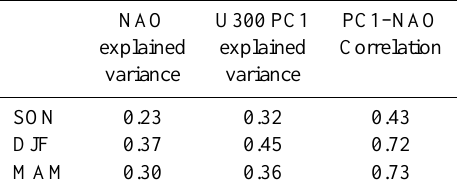
Table 1. Variance explained by the NAO (Hurrel et al., 2003) and by the 1st PC of the 300hPa zonal wind (PC1) over North Atlantic; correlation between the NAO and the PC1 time-series.